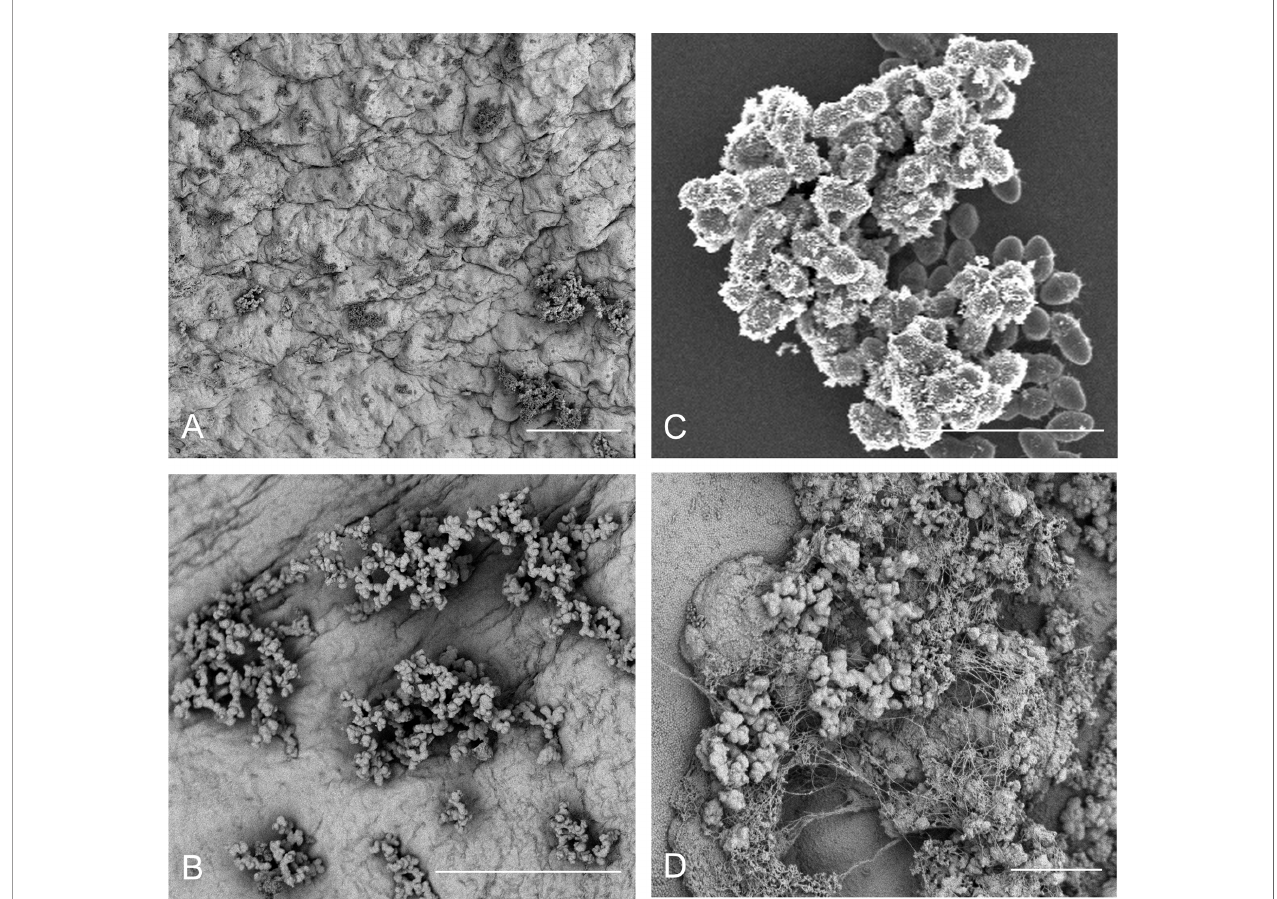
FIGURE 2 | E. faecalis attachment, microcolony formation, and bio fi lm development on a range of in vitro and in vivo substrates demonstrates morphological conservation. (A) OG1RF attachment and microcolony development in a leporine model of endovascular infection (96 hr) with pre-inoculation mechanical damage to the aortic valve via catheterization (bar = 50 m m); (B) OG1RF attachment and microcolony development in a leporine model of endovascular infection (96 hr) from an uncatheterized rabbit (bar = 50 m m); (C) E. faecalis OG1RF microcolony formation in vitro on an Aclar fl uoropolymer membrane (8 hr; bar = 5 m m). (D) OG1RF colonization of the GI tract in a germ-free murine model (72 hr; bar = 5 m